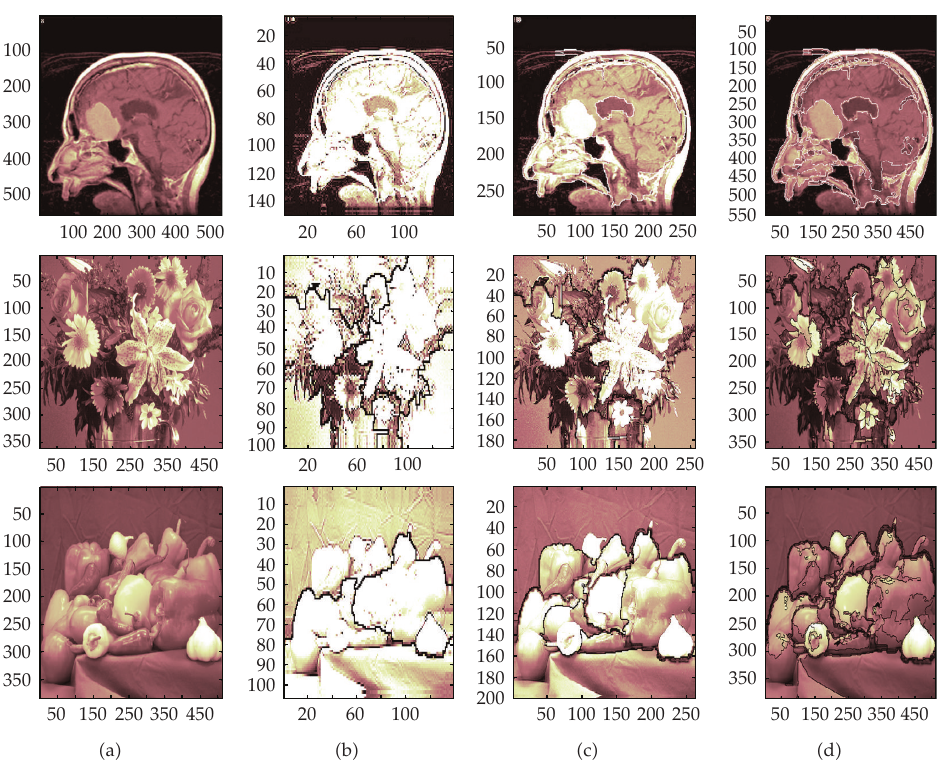
Figure 7: Final segmented images on wavelet decomposition from level 2 to level 0. (cid:3) a (cid:4) Original image and, (cid:3) b (cid:4) to (cid:3) d (cid:4) are the watershed imposed original images from low-resolution (cid:3) 64 × 64 (cid:4) to high-resolution (cid:3) 256 × 256 (cid:4)